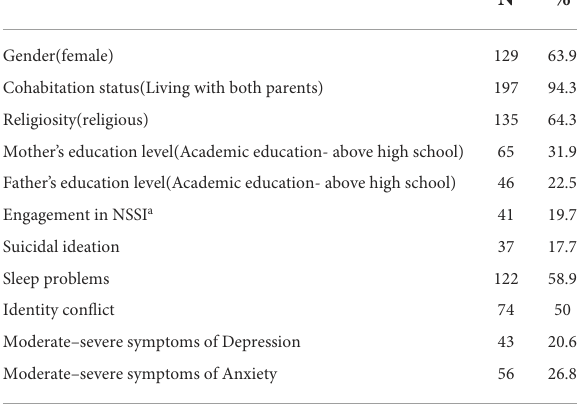
TABLE 1 Demographic and clinical characteristics of the